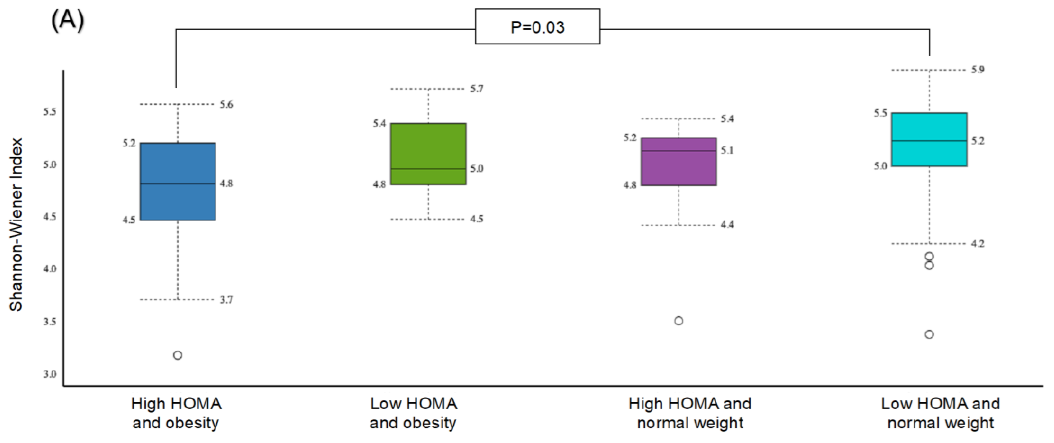
Figure 4. Comparison of bacterial diversities between the gut microbiota of the groups with high HOMA and high fat%, high HOMA and low fat%, low HOMA and high fat% and low HOMA and low fat%: ( A ) α -diversity, ( B ) β -diversity.